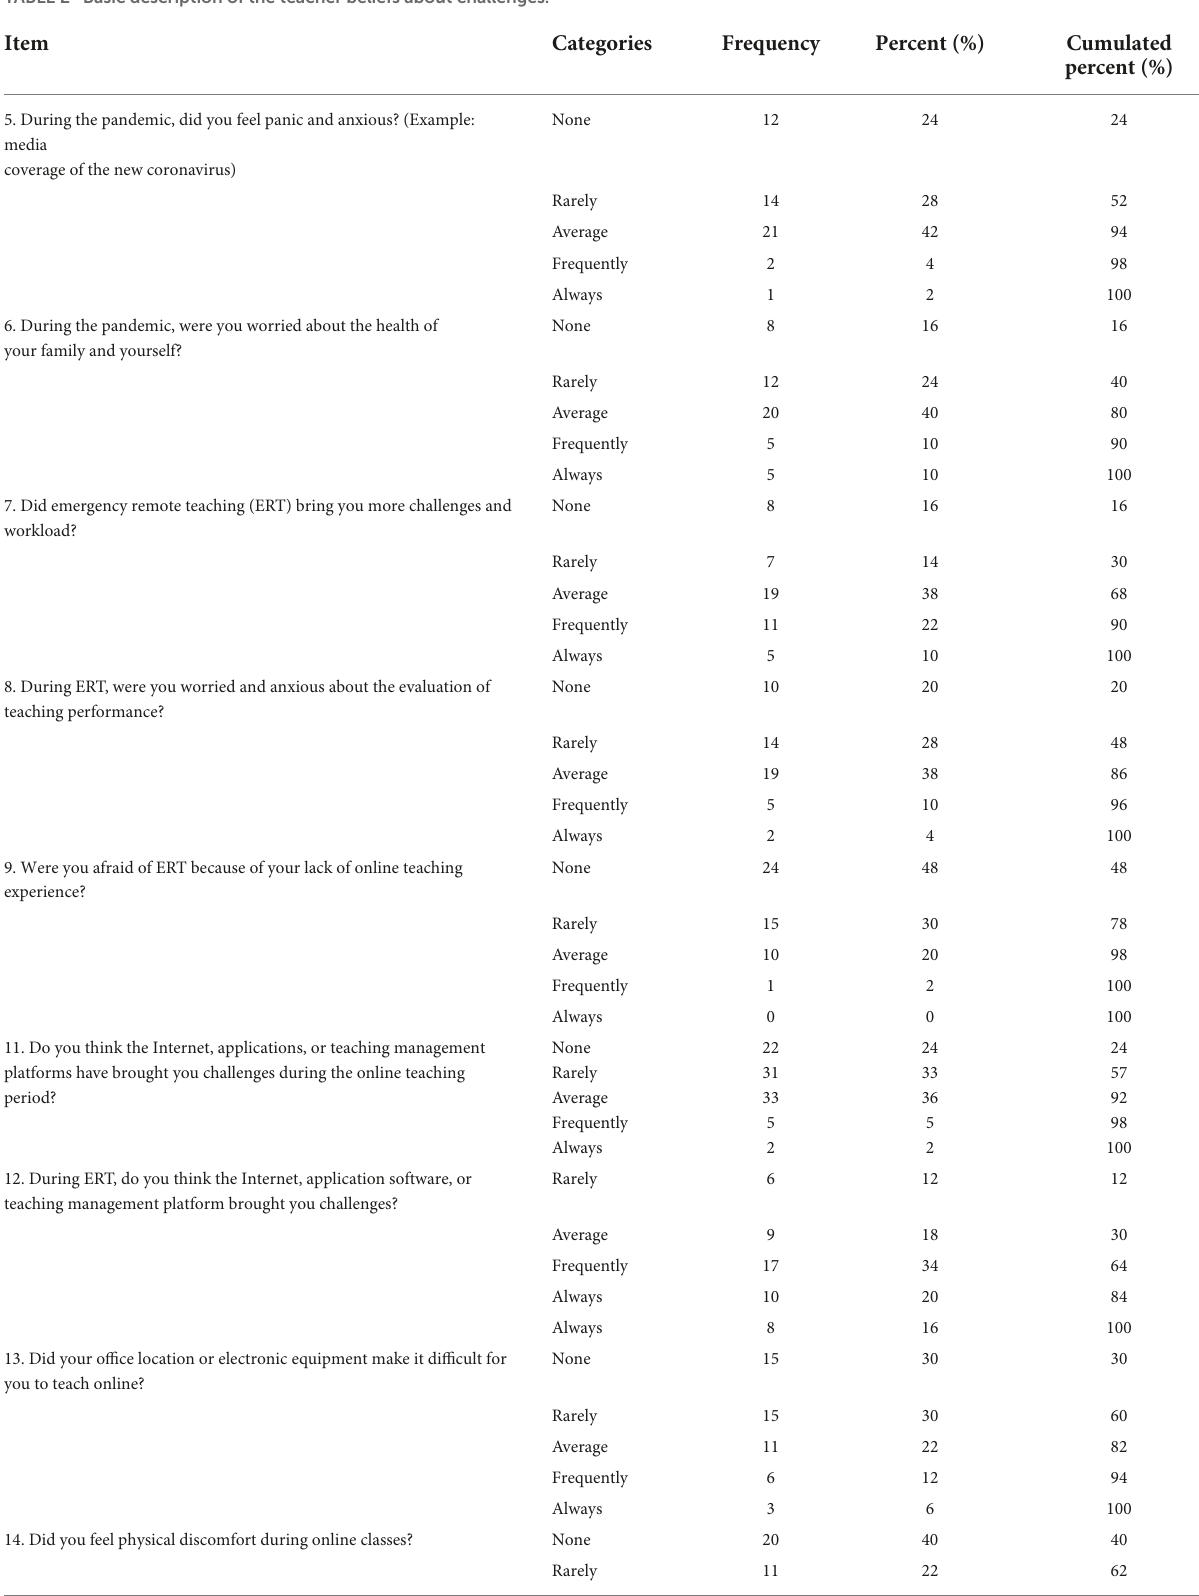
TABLE 2 Basic description of the teacher beliefs about